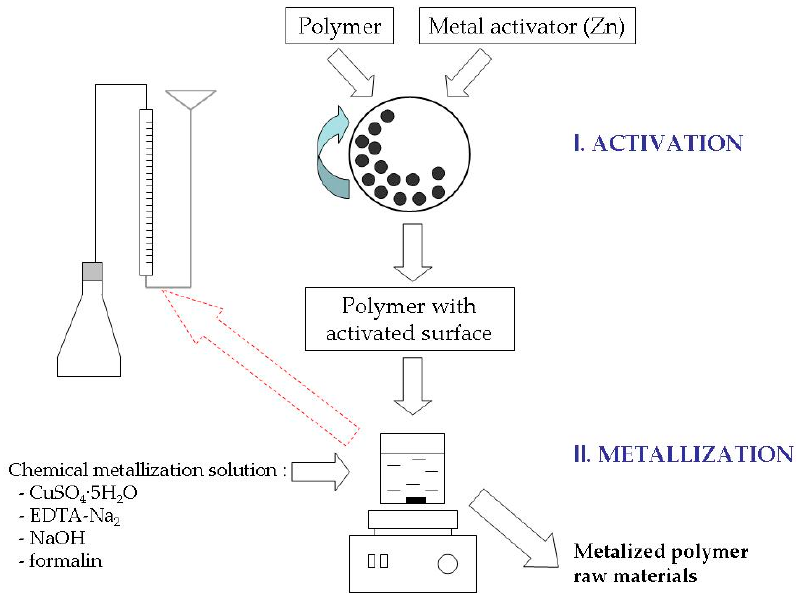
Figure 2. Scheme of obtaining metalized polymeric raw materials.